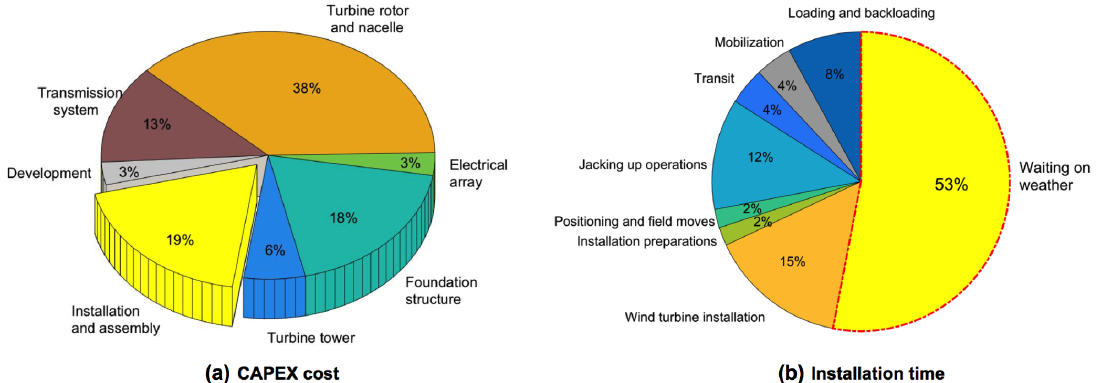
Figure 1. ( a ) Cost breakdown for different components of CapEx for OWT project; ( b ) contribution of different activities during installation and assembly activities (statistics based on 2016–2017 data from